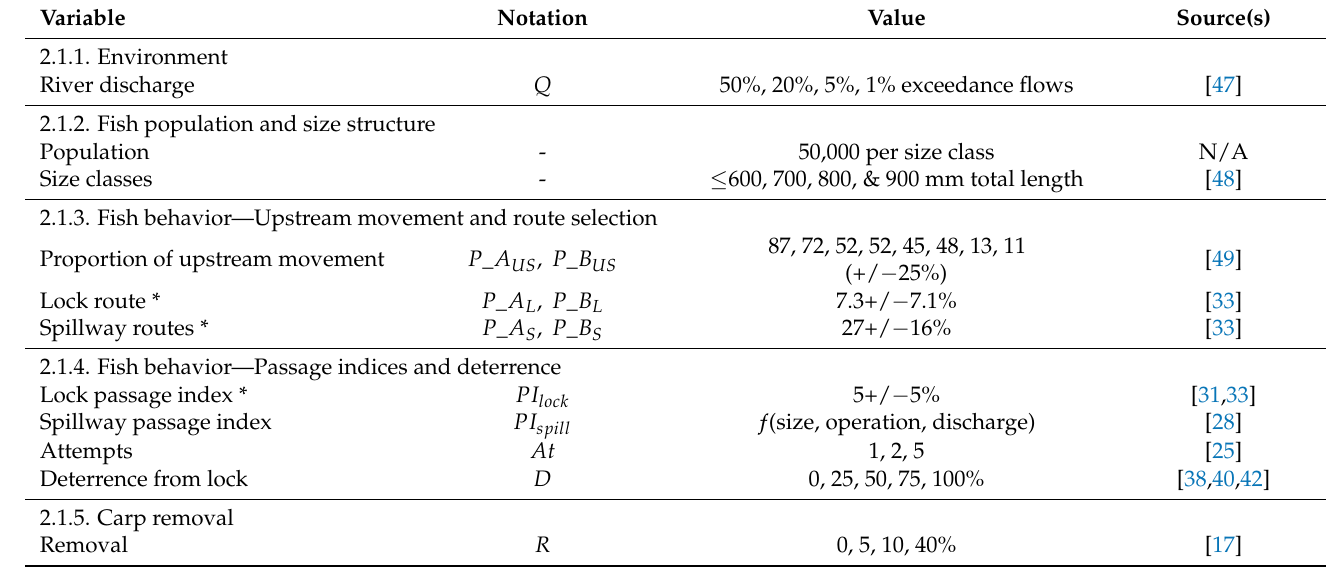
Table 2. List of stochastic size-structured fish passage model (S-PFM) variables and values. Where available, variable mean +/ − standard deviation is provided. Variables are categorized by italicized section headings and further described in the methods. Data derived from common carp are noted with an (*), otherwise data come from silver carp. Q is river discharge. P _ A US , P _ B US are the proportions of fish that move upstream at LD A and LD B. P _ A L , P _ B L and P _ A S , P _ B S are the proportions of upstream swimming fish to atempt passage through the lock and spillway gates at each LD, respectively. PI lock , PI spill are the passage indices at the lock and spillway gates. At is the number of passage attmpts made per month at the spillway gates. D is the efficiency of a deterrent system inhibiting passage through the lock chamber. R is the proportion of fish removed from the intermediate